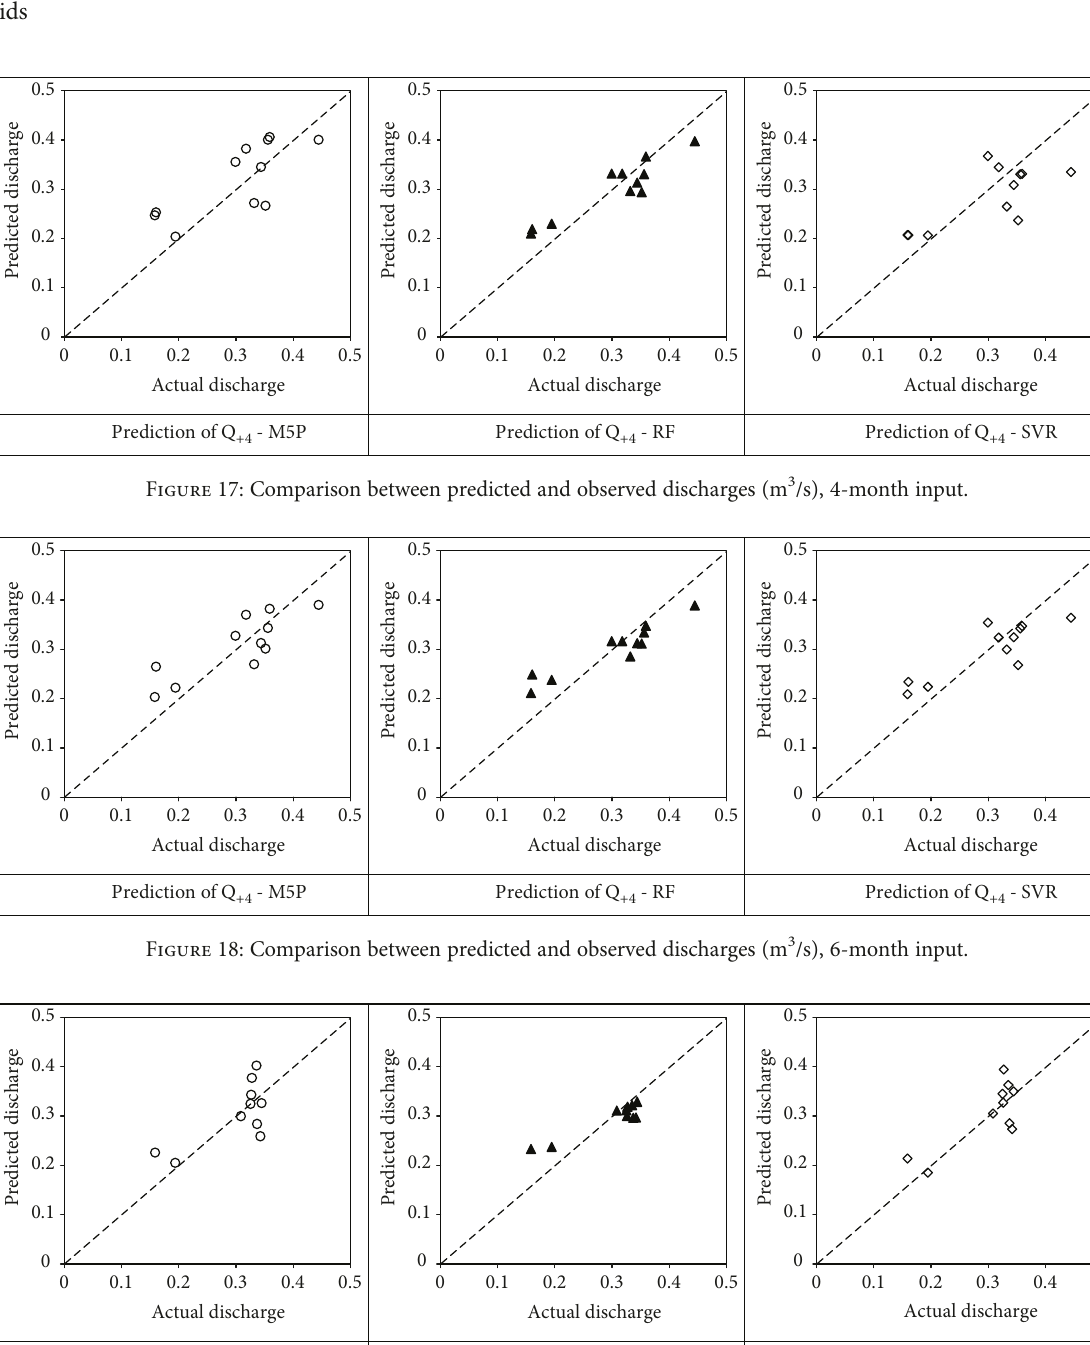
Prediction of Q + 4 - M5P Figure 19: Comparison between predicted and observed discharges (m 3 /s), 8-month